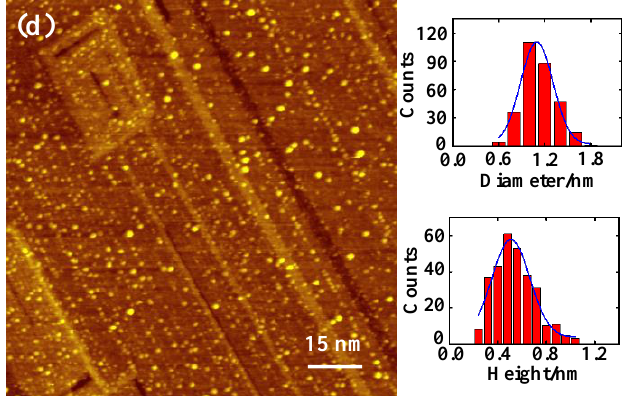
Figure 1. STM images for 0.5-MLe Rh deposited on a thin film of Al 2 O 3 /NiAl(100) at ( a ) 300 K and annealed stepwise to ( b ) 450, ( c ) 570 and ( d ) 800 K. The insets in ( a – d ) show characteristic histograms of height and diameter for each temperature; the curves are the best Gaussian fits to the distributions.